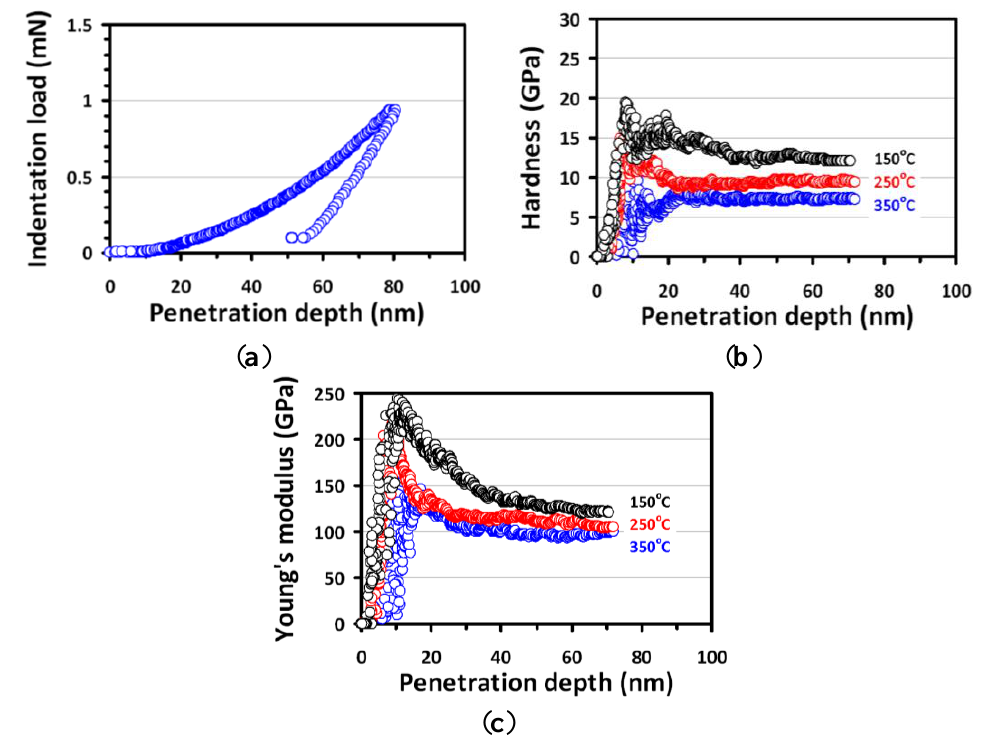
O thin films deposited at 350 2